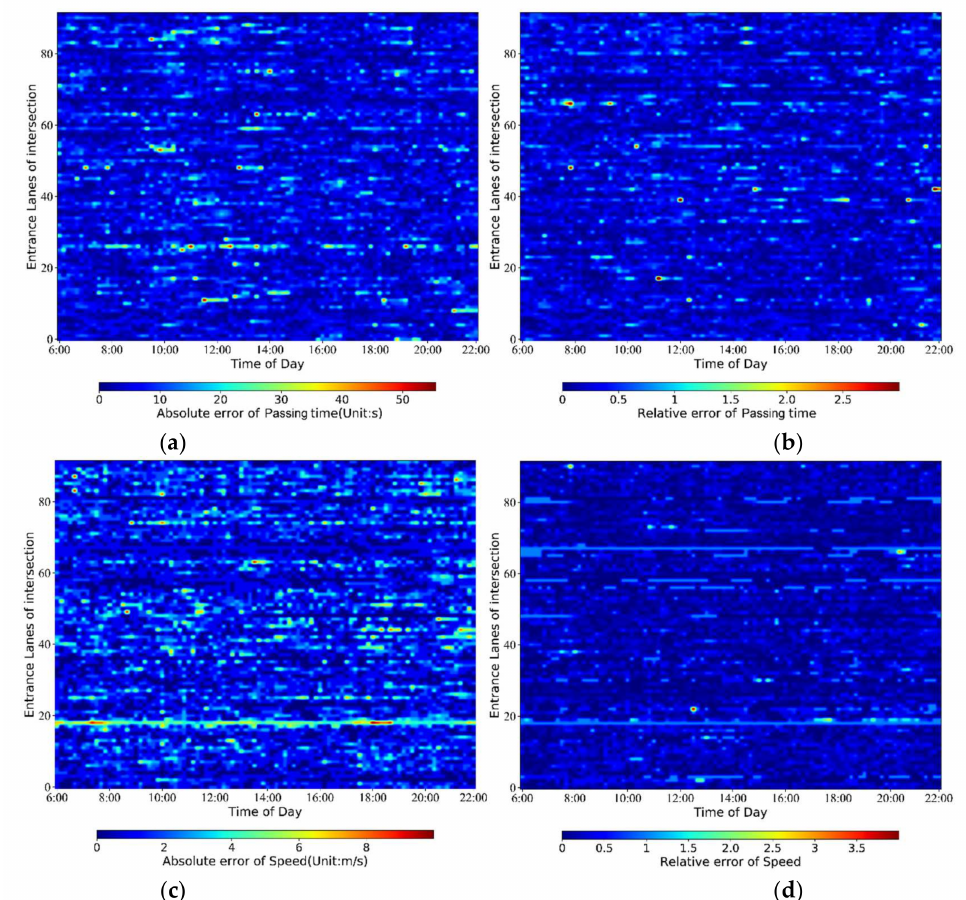
Figure 16. The absolute errors and the relative errors of MFDL: ( a ) the absolute errors of the passing time; ( b ) the relative errors of the passing time; ( c ) the absolute errors of speed; ( d ) the relative errors of